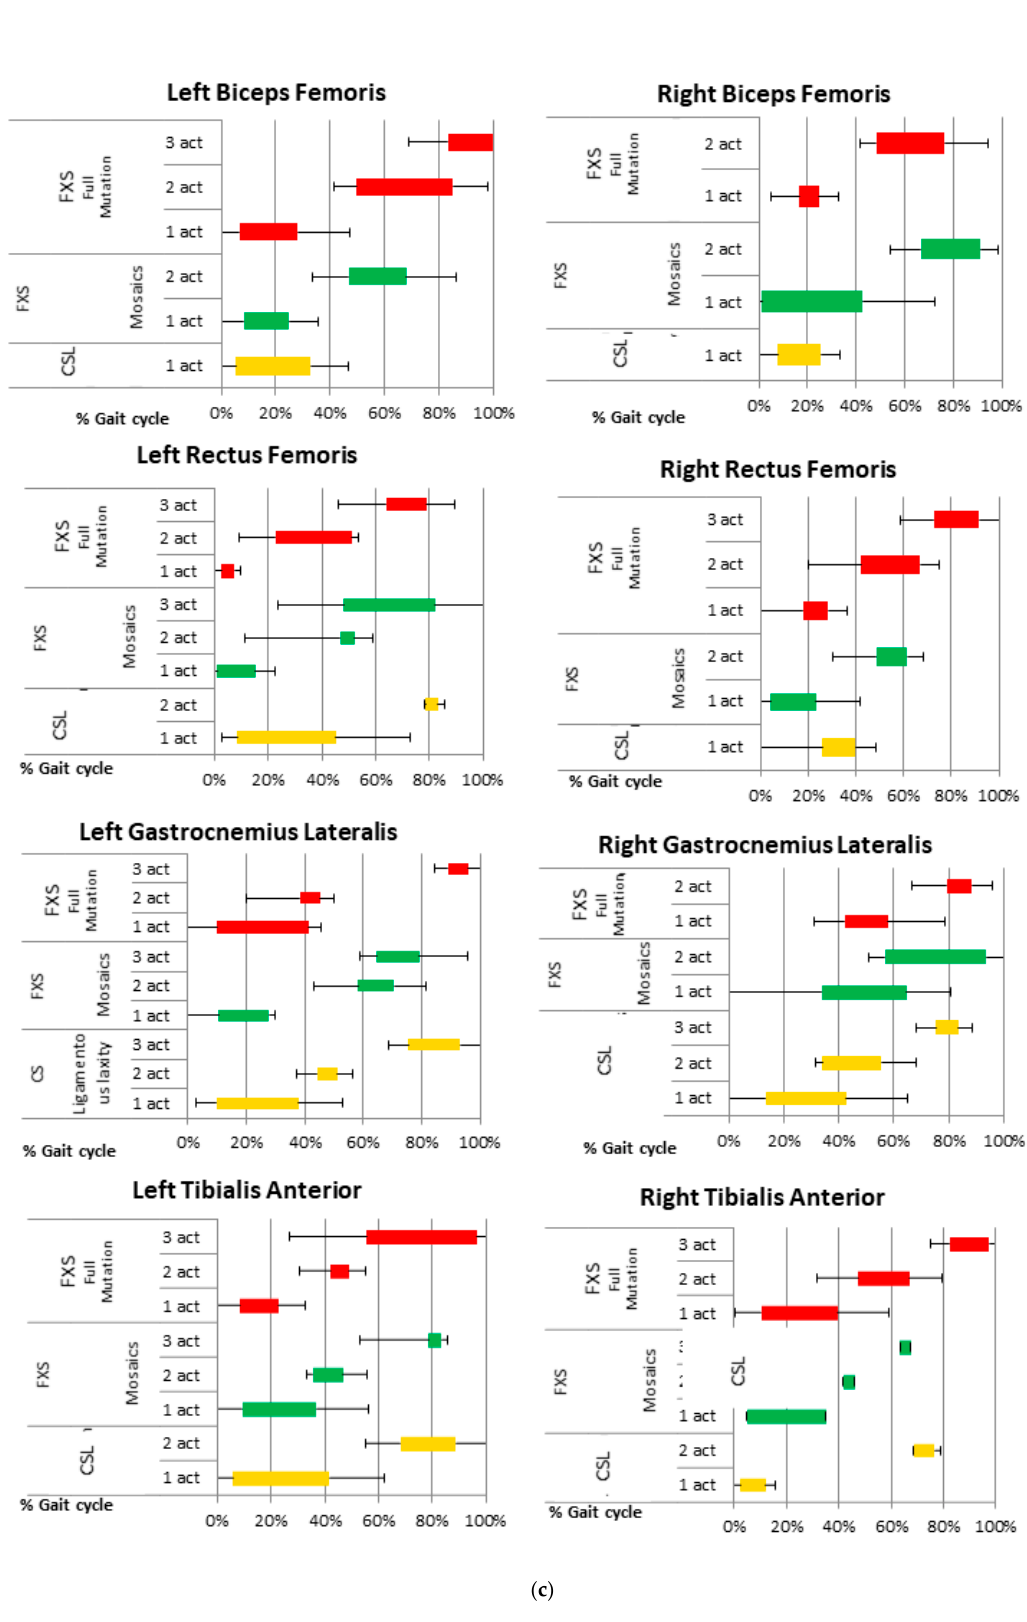
Figure 5. ( a – c ) Histograms presenting intervals of muscle activation during gait in FXS subjects and CS (mean values and ±1 SD), bilaterally for the following muscles: Biceps Femoris, Rectus Femoris, Gastrocnemius Lateralis, Tibialis Anterior. FXS Full Mutation (red), FXS Mosaics (green) and CS (grey, Figure 5a), CSF (purple, Figure 5b), CSL (yellow, Figure 5c). Colours refer to the online version of the